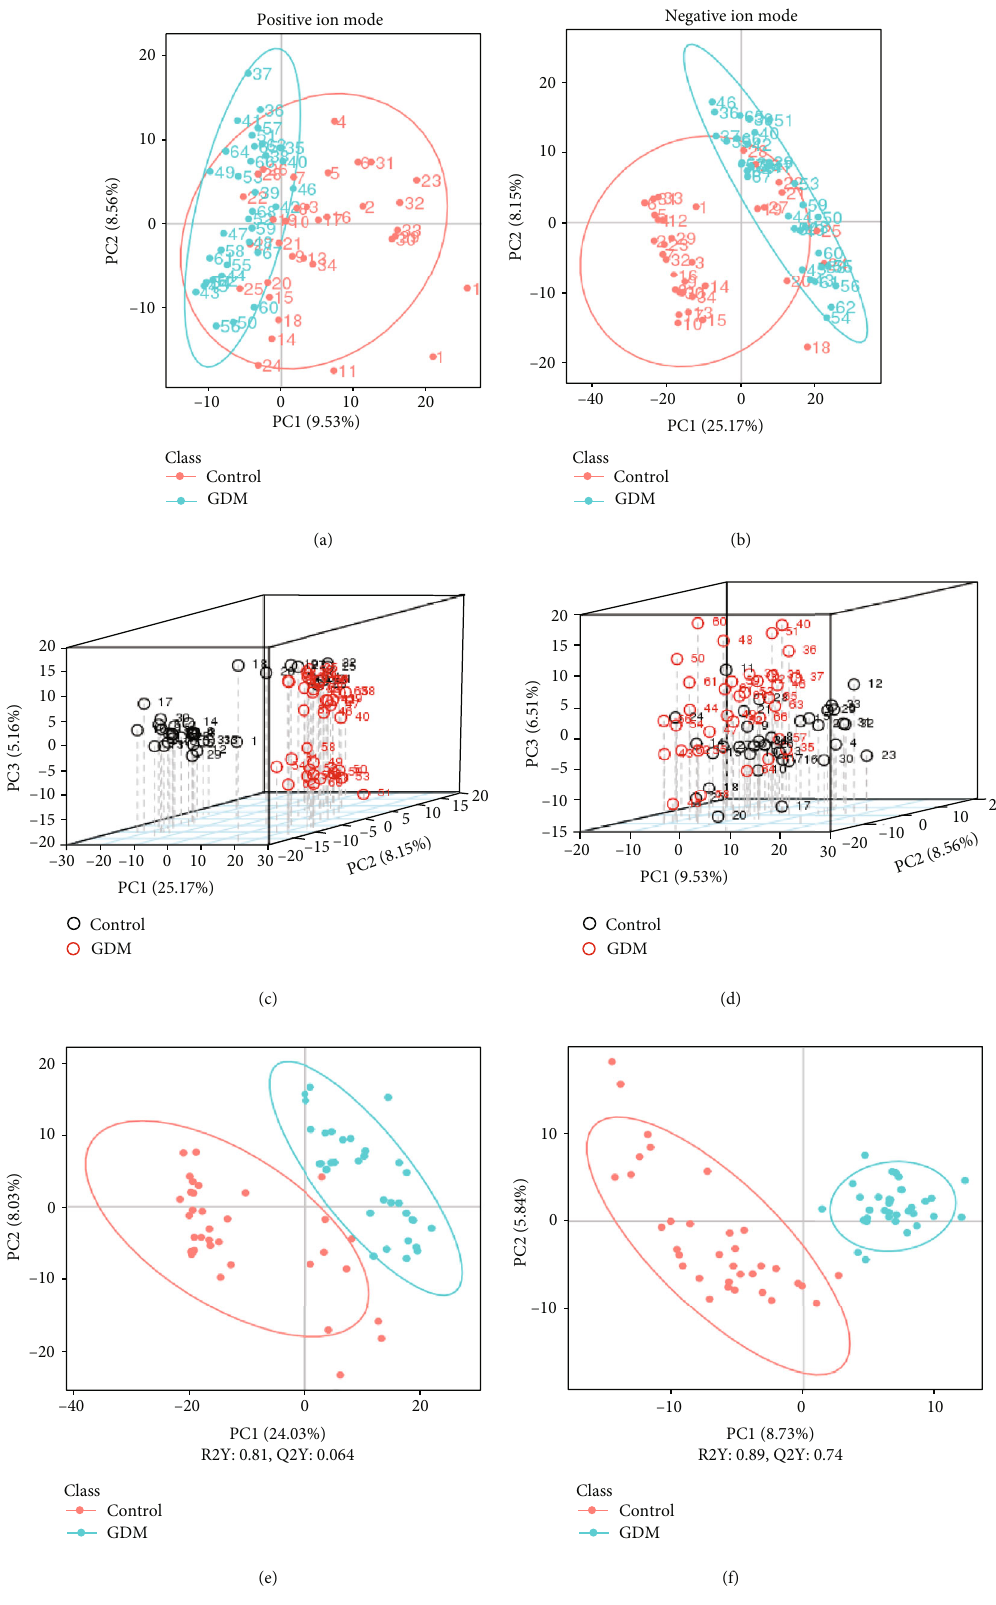
Figure 1: Metabolomic analysis of control and GDM. (a, b) PCA analysis between control and GDM. (c, d) 3D score plot of PCA analysis between control and GDM. (e, f) PLS-DA analysis between control and GDM, (a, c, e) Positive ion mode. (b, d, f) Negative ion